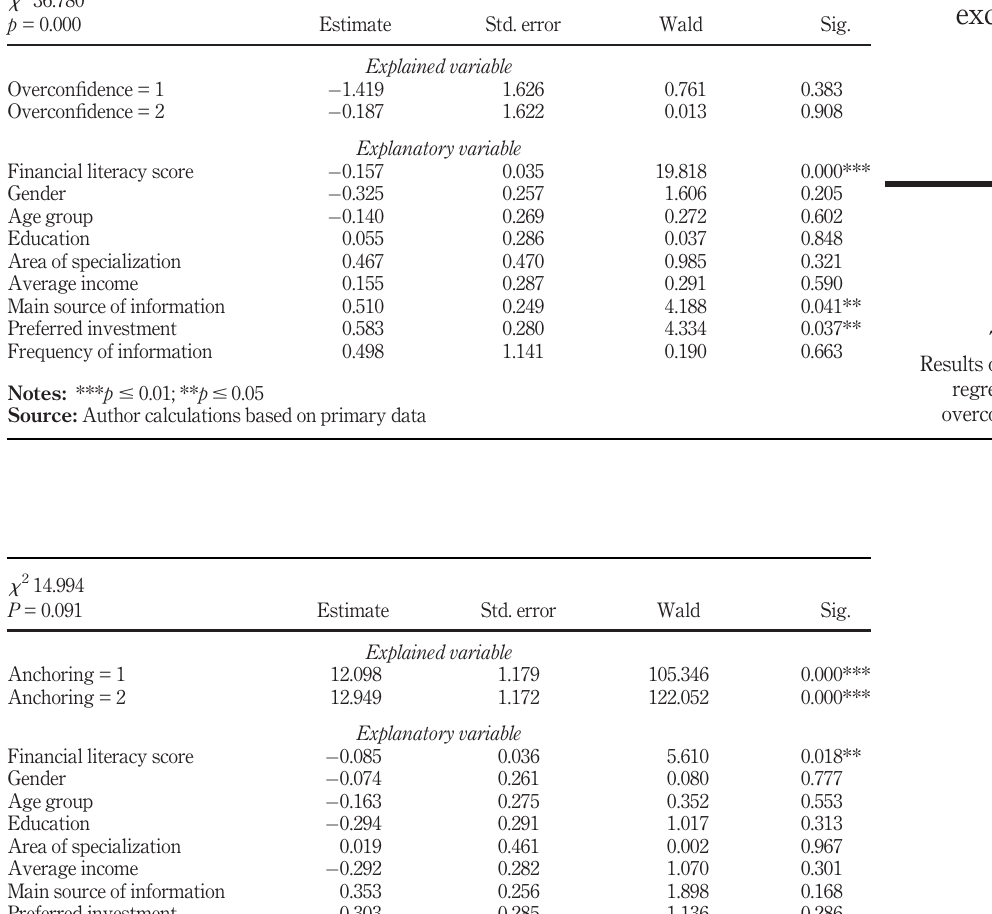
Table 8. Results of ordinal regression for anchoring